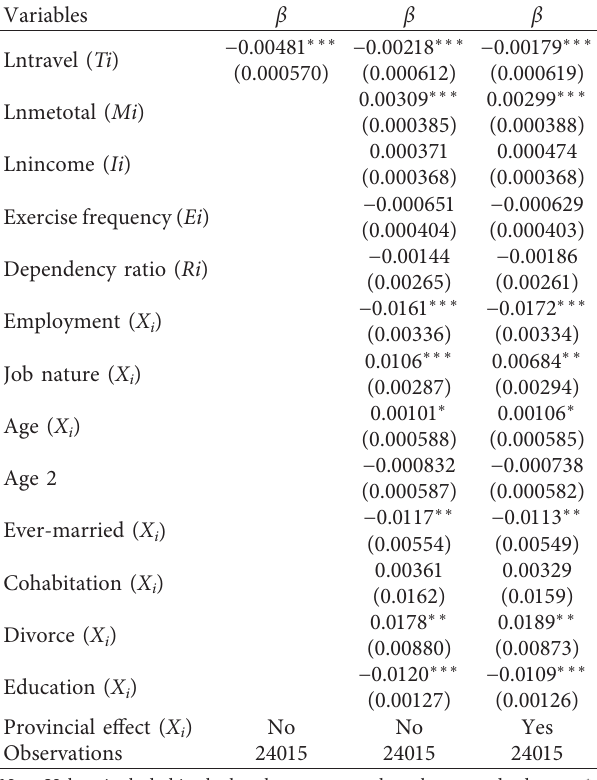
Table 2: The impact of Probit model on estimation result of sad mood based on cross-sectional